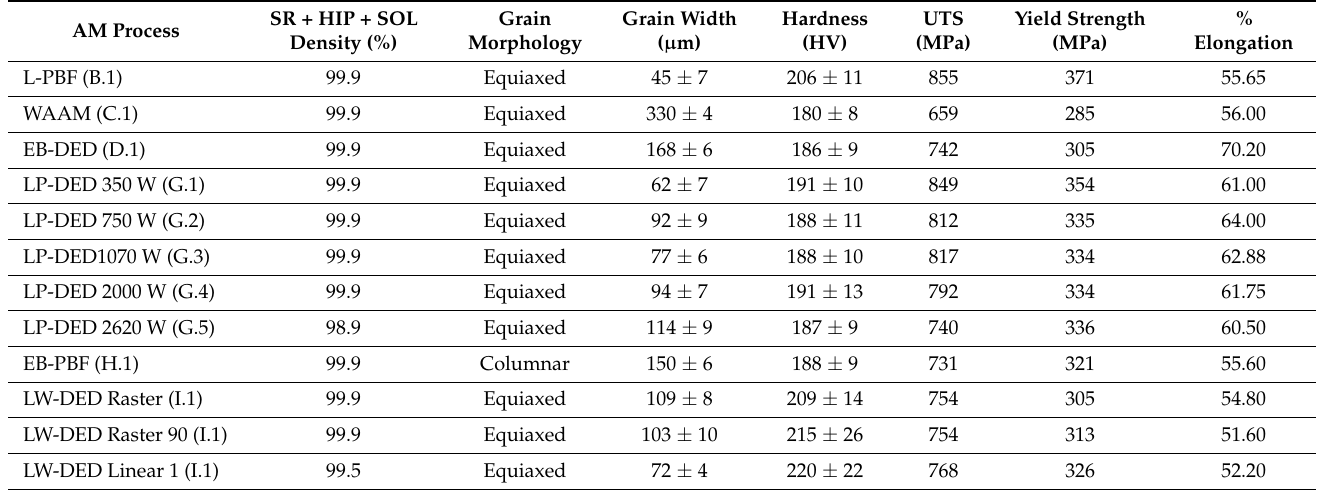
Table 3. Summary of AM process microstructures, mechanical and related properties for heat-treated (SR + HIP + SOL)